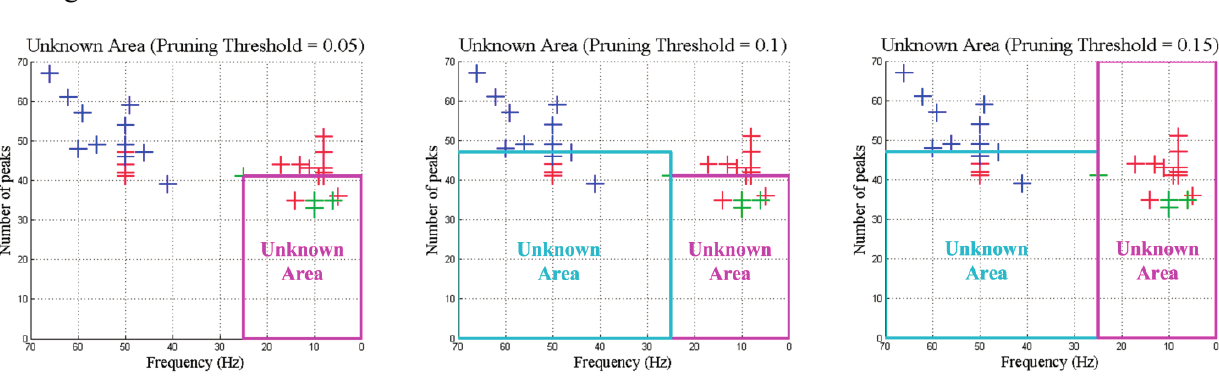
Figure 13. Evolution of “Unknown Area”.